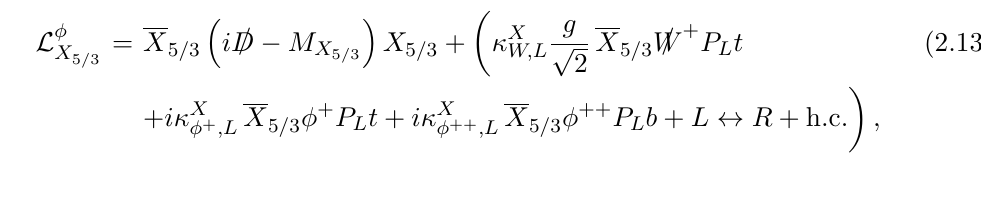
in the benchmark 6